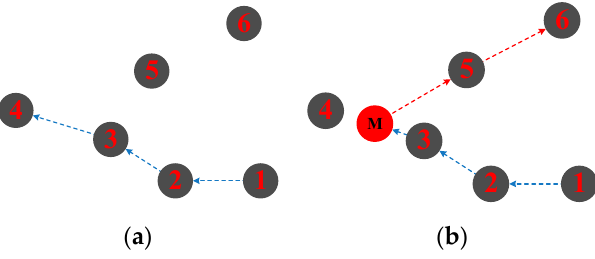
Figure 5. Misdirection attack; ( a ) normal route; ( b ) misdirection route.